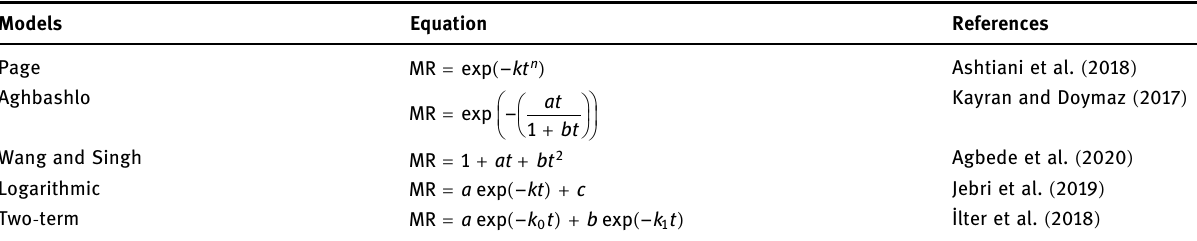
Table 1: Empirical mathematical models for drying kinetics